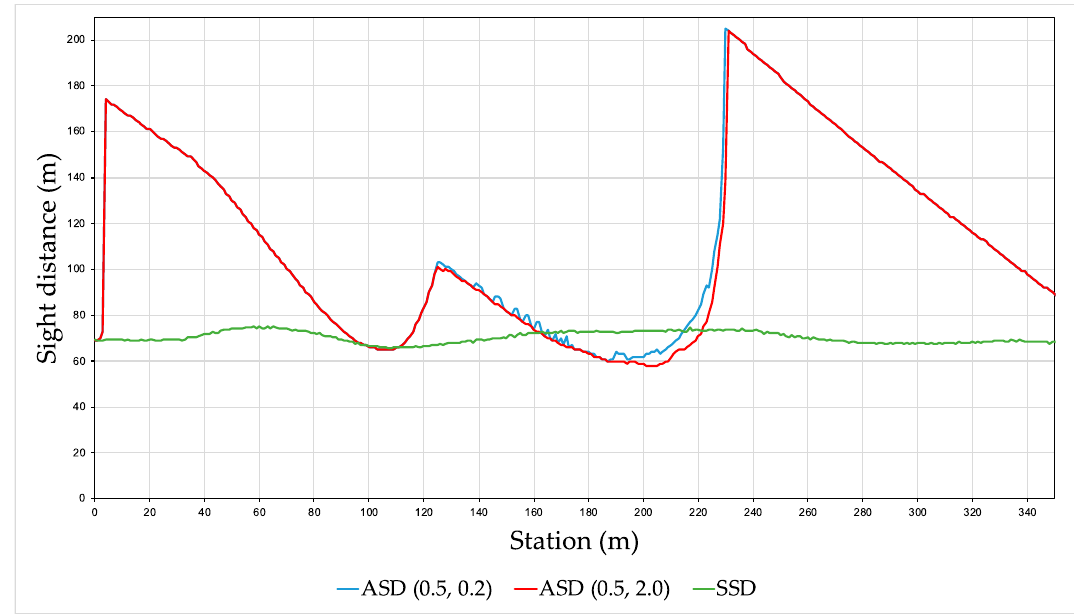
Figure 7. Visibility results with distinct resolutions for aboveground elements.